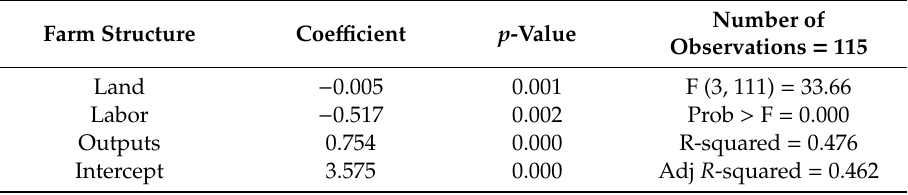
Figure A1. Scatterplot matrix; Farm structure: land, labor, livestock, and standard output; Source: own calculation . Table A3. The relation of the composite indicator of farm structure and the original data; Source: own calculation .